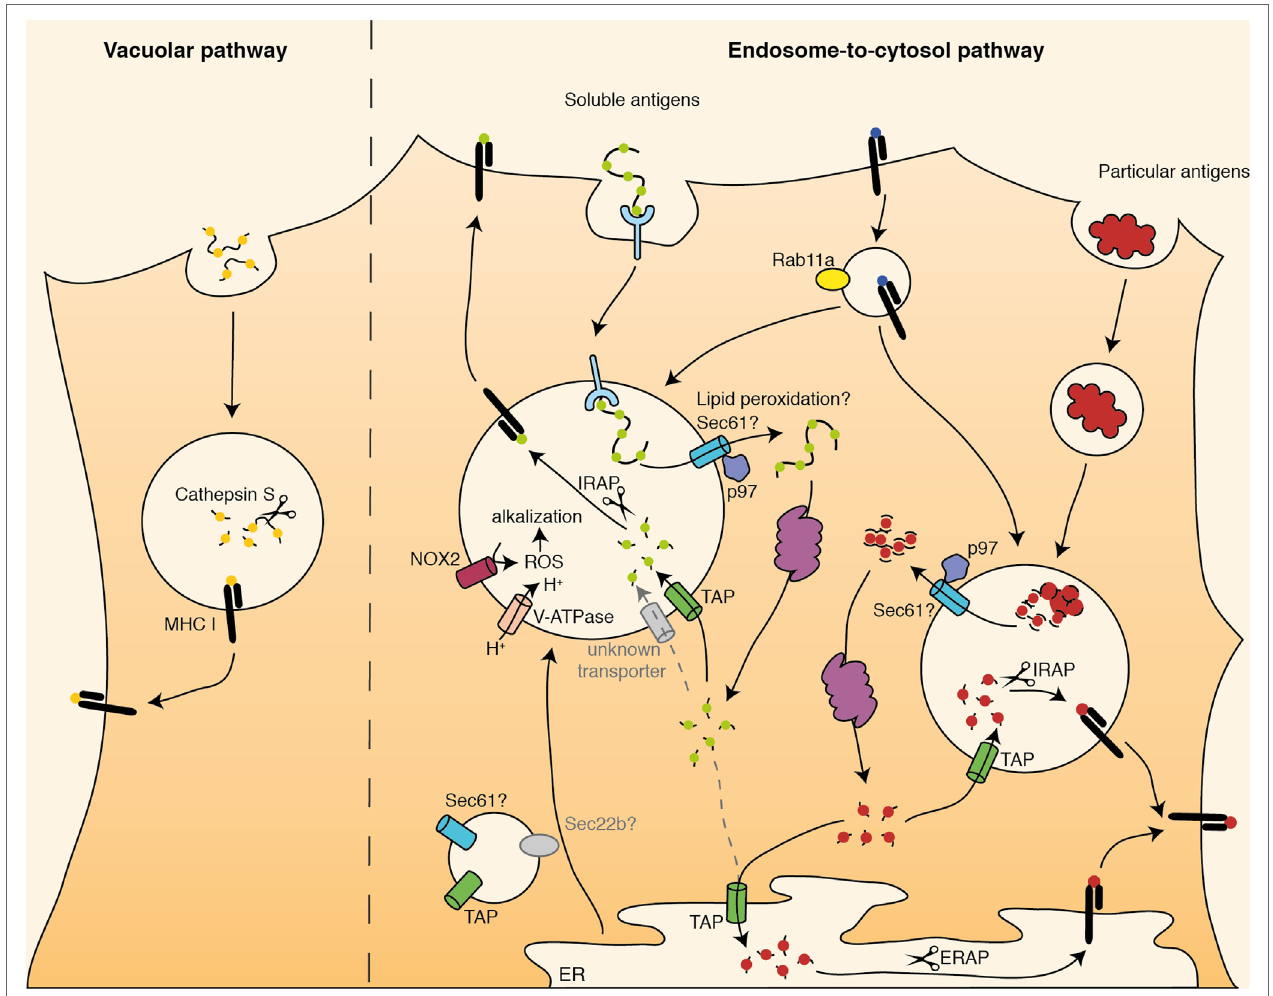
FiGURe 1 | Schematic overview of cross-presentation pathways. Internalized antigens can be presented via the vacuolar pathway or via the endosome-to-cytosol pathway. In the vacuolar pathway, antigens are degraded in endosomes by Cathepsin S and loaded onto major histocompatibility complex (MHC) I there. In the endosome-to-cytosol pathway, antigens are transported into the cytosol for proteasomal degradation. Afterward, antigen-derived peptides are transported back into the endosomes (soluble and particular antigens) or into the ER (particular antigens) via TAP. There, they are trimmed by IRAP (endosomes) or ERAP (ER) and loaded onto MHC I. They cross-presentation machinery might be translocated toward endosomes via